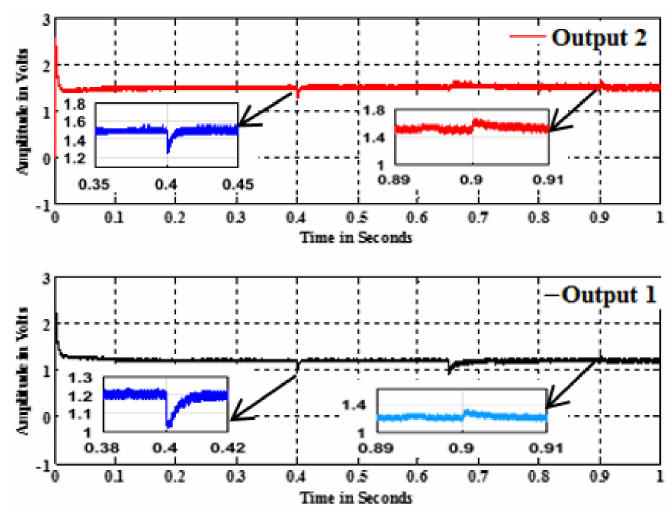
Figure 12. Closed loop response of the SIDO converter with LQR controller with load disturbances.